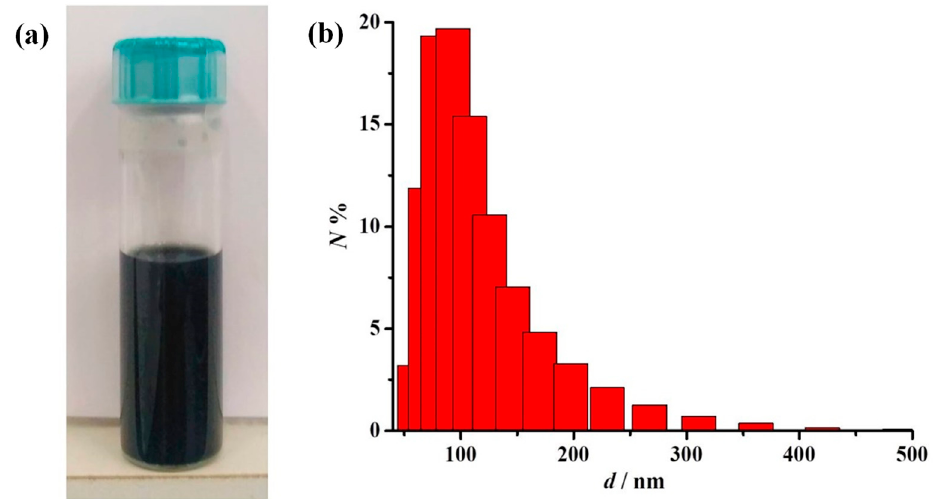
Figure 5. ( a ) The M-GNS ink after 24 h at rest after preparation; and ( b ) a histogram of the prepared M-GNS ink from Dynamic light scattering (DLS) measurements, recorded in an aqueous medium with a sample dilution of φ = 1:33.